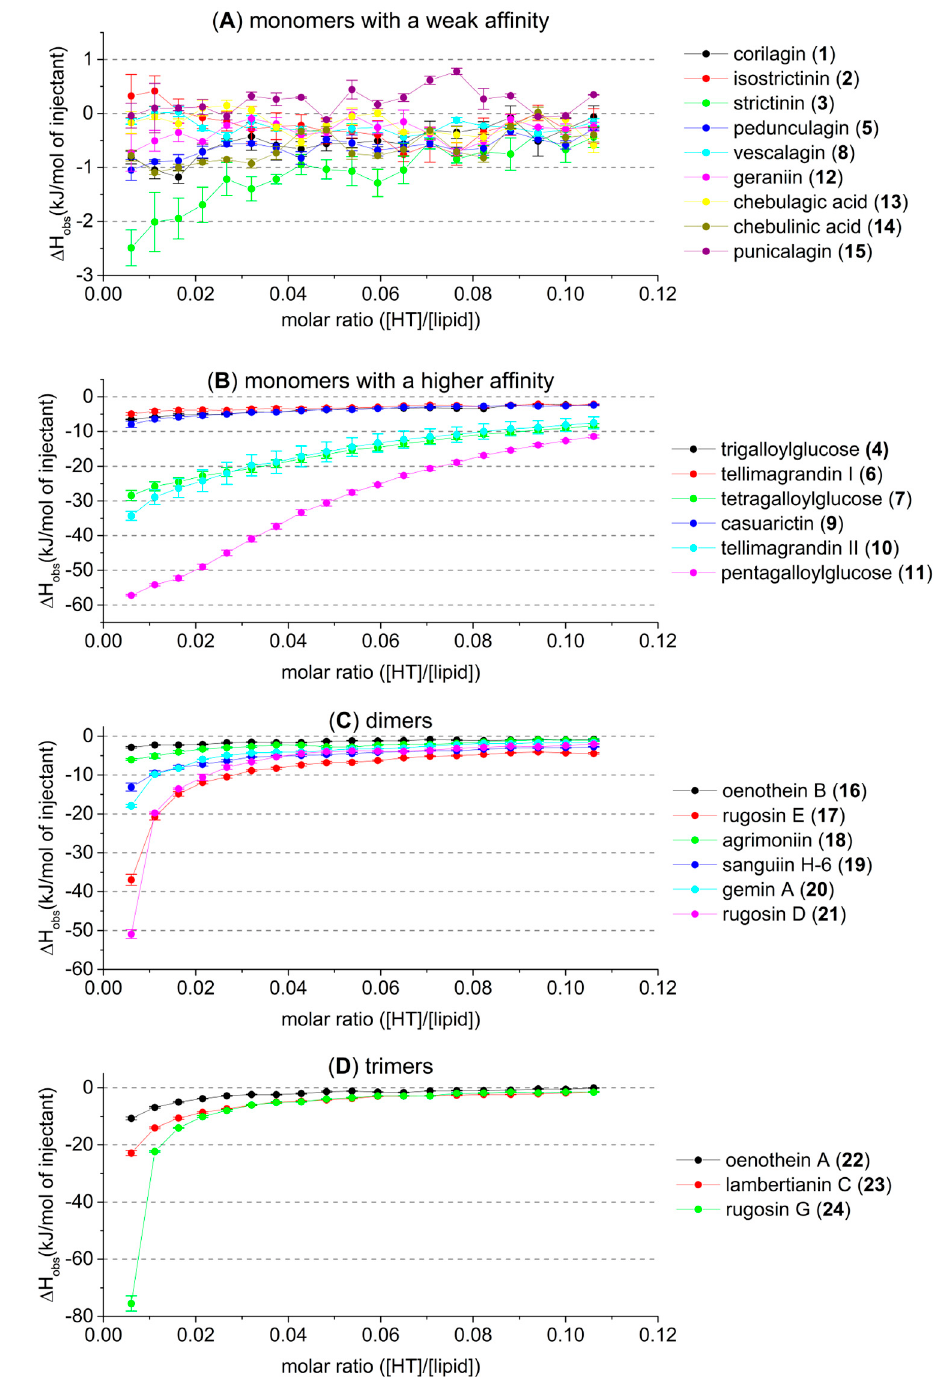
Figure 3. Observed heat rates of injection of studied hydrolysable tannins (HTs) when titrated into a 2 mM E. coli lipid vesicle solution as a function of the molar ratio ([HT]/[lipid]) in the sample cell: ( A ) monomers with a weak affinity; ( B ) monomers with a higher affinity; ( C ) dimeric and ( D ) trimeric HTs. Heat rates presented as kJ/mol of injectant with average values and standard error, n = 3. For HT structures refer to Figures 1 and 2.